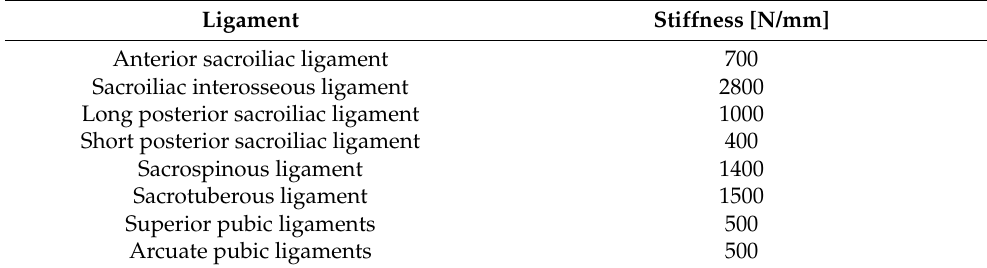
Table 1. Main pelvic ligaments included in the FEM model [22].